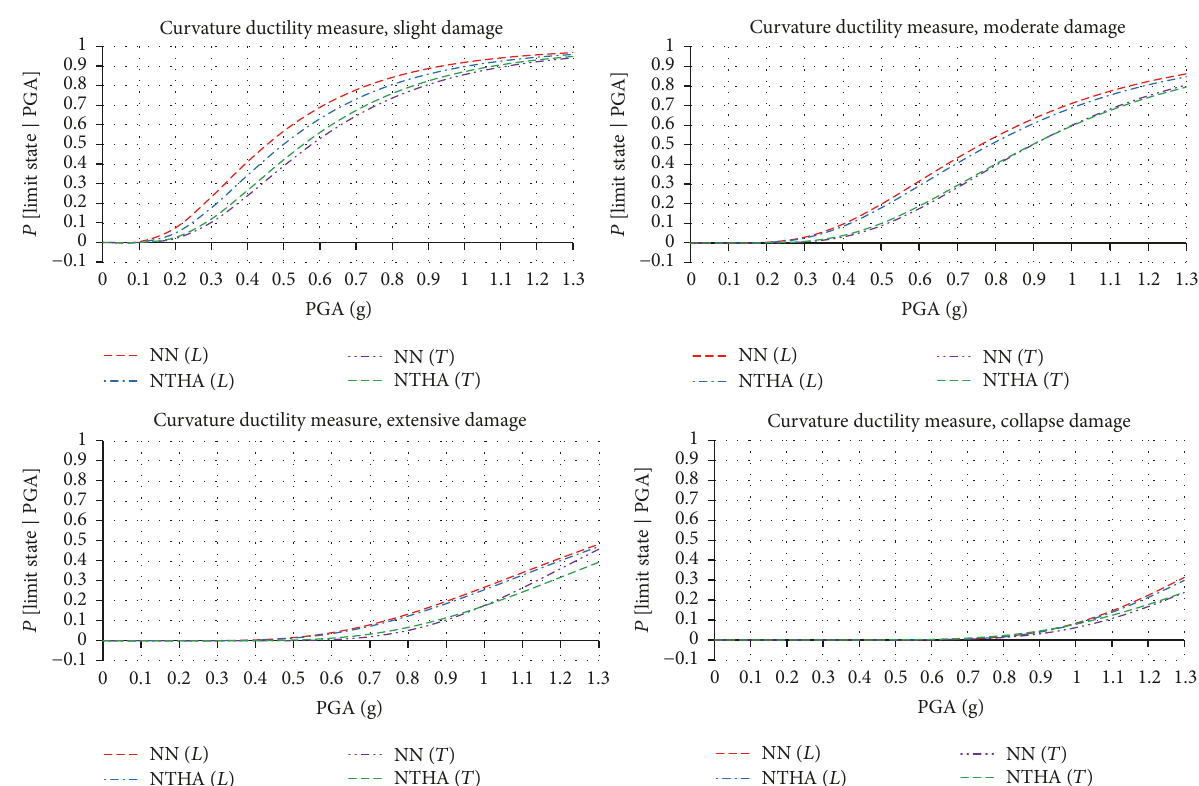
Figure 14: Comparison of the column fragility curves by NN (Approach 2) and NTHA